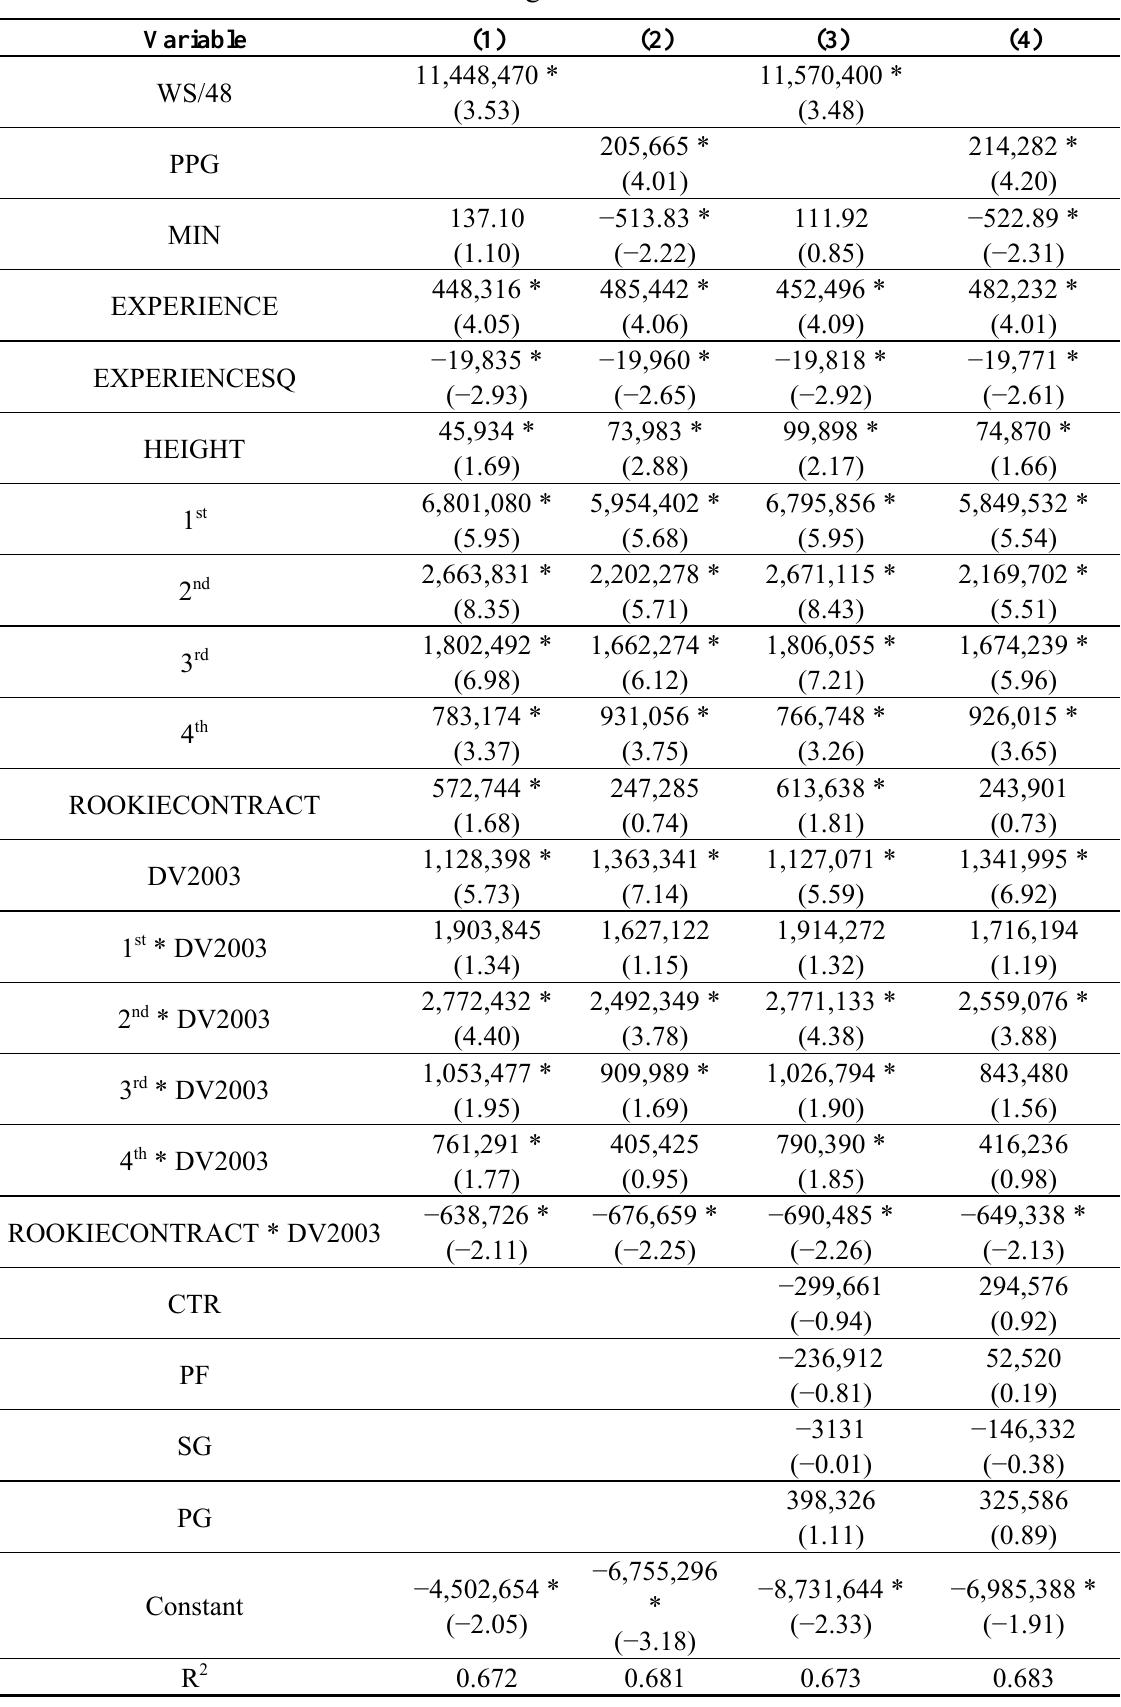
Table 2. Regression